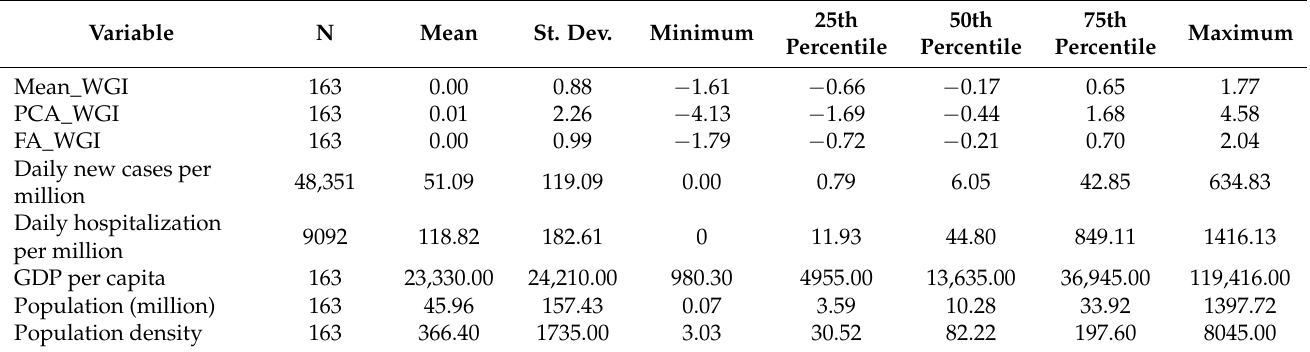
Table 3. Descriptive statistics of explanatory and control